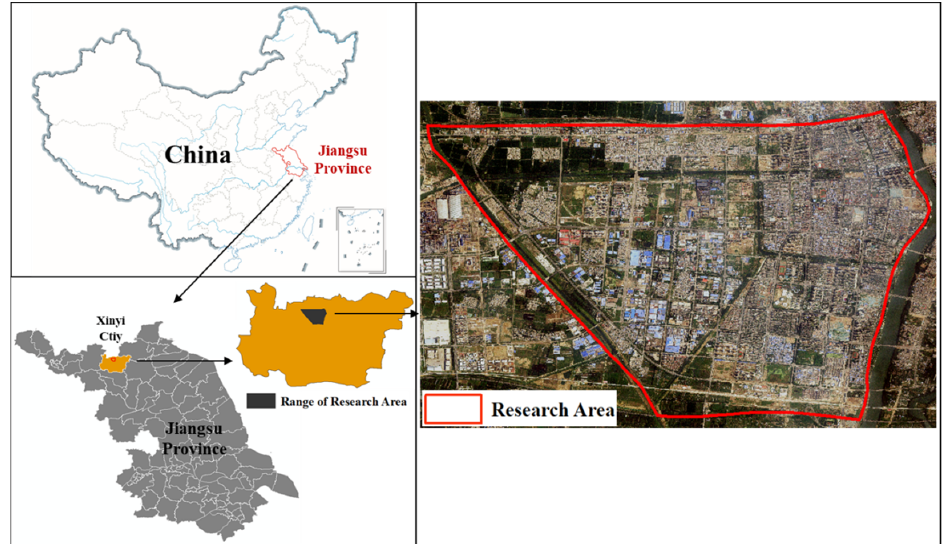
Figure 1. The location and range of the study area.